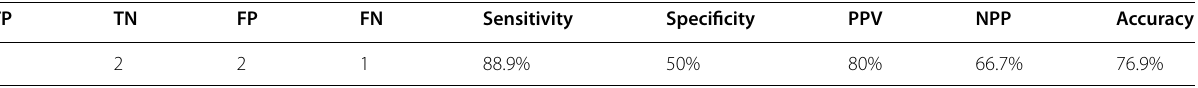
TP true positive, TN true negative, FP false positive, FN false